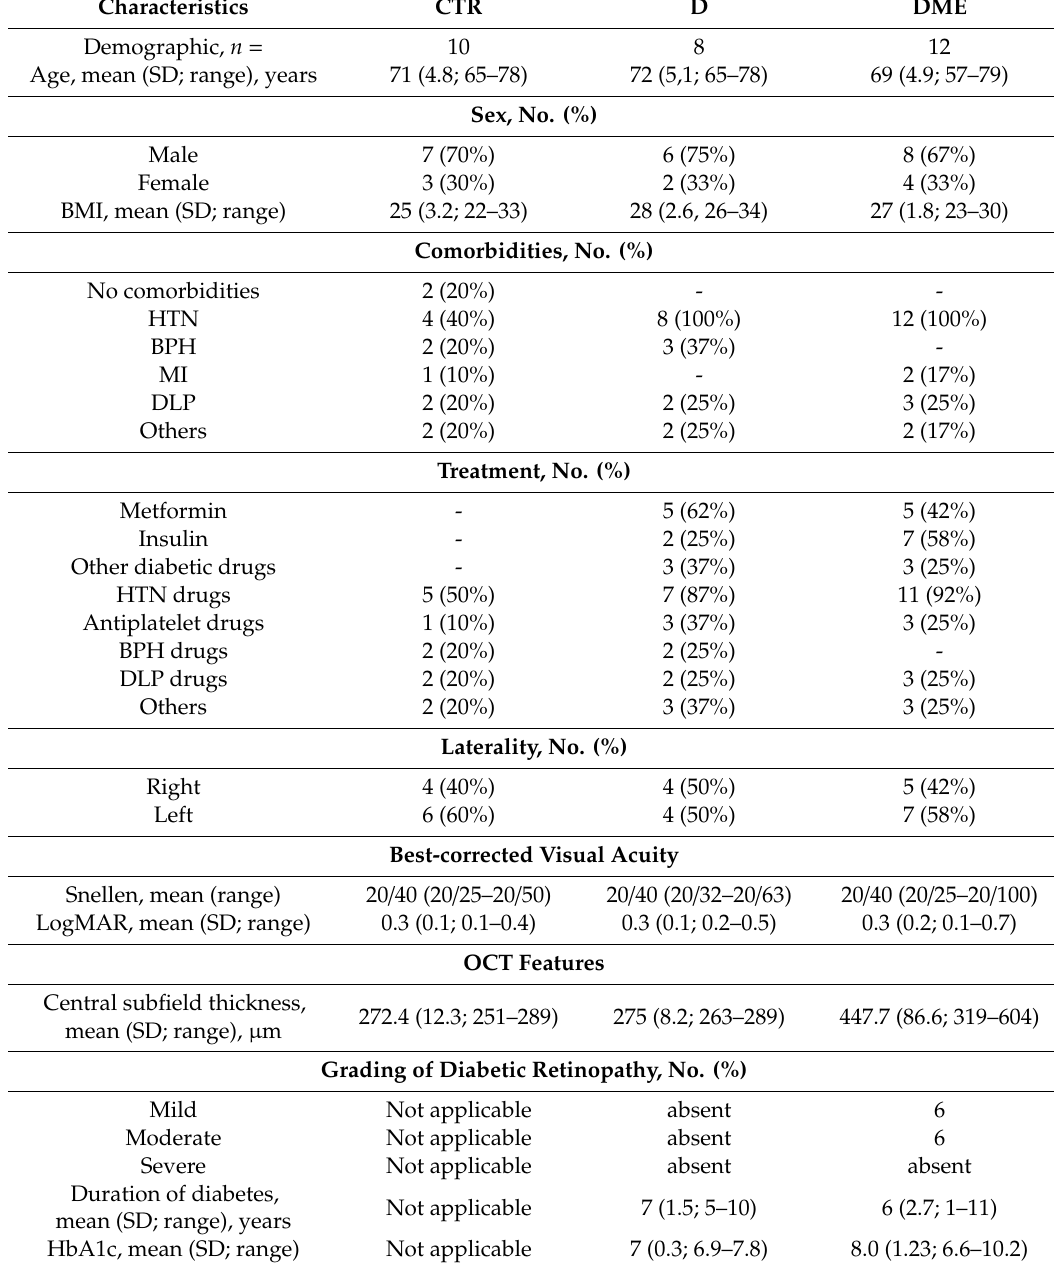
Table 1. Clinical characteristics of